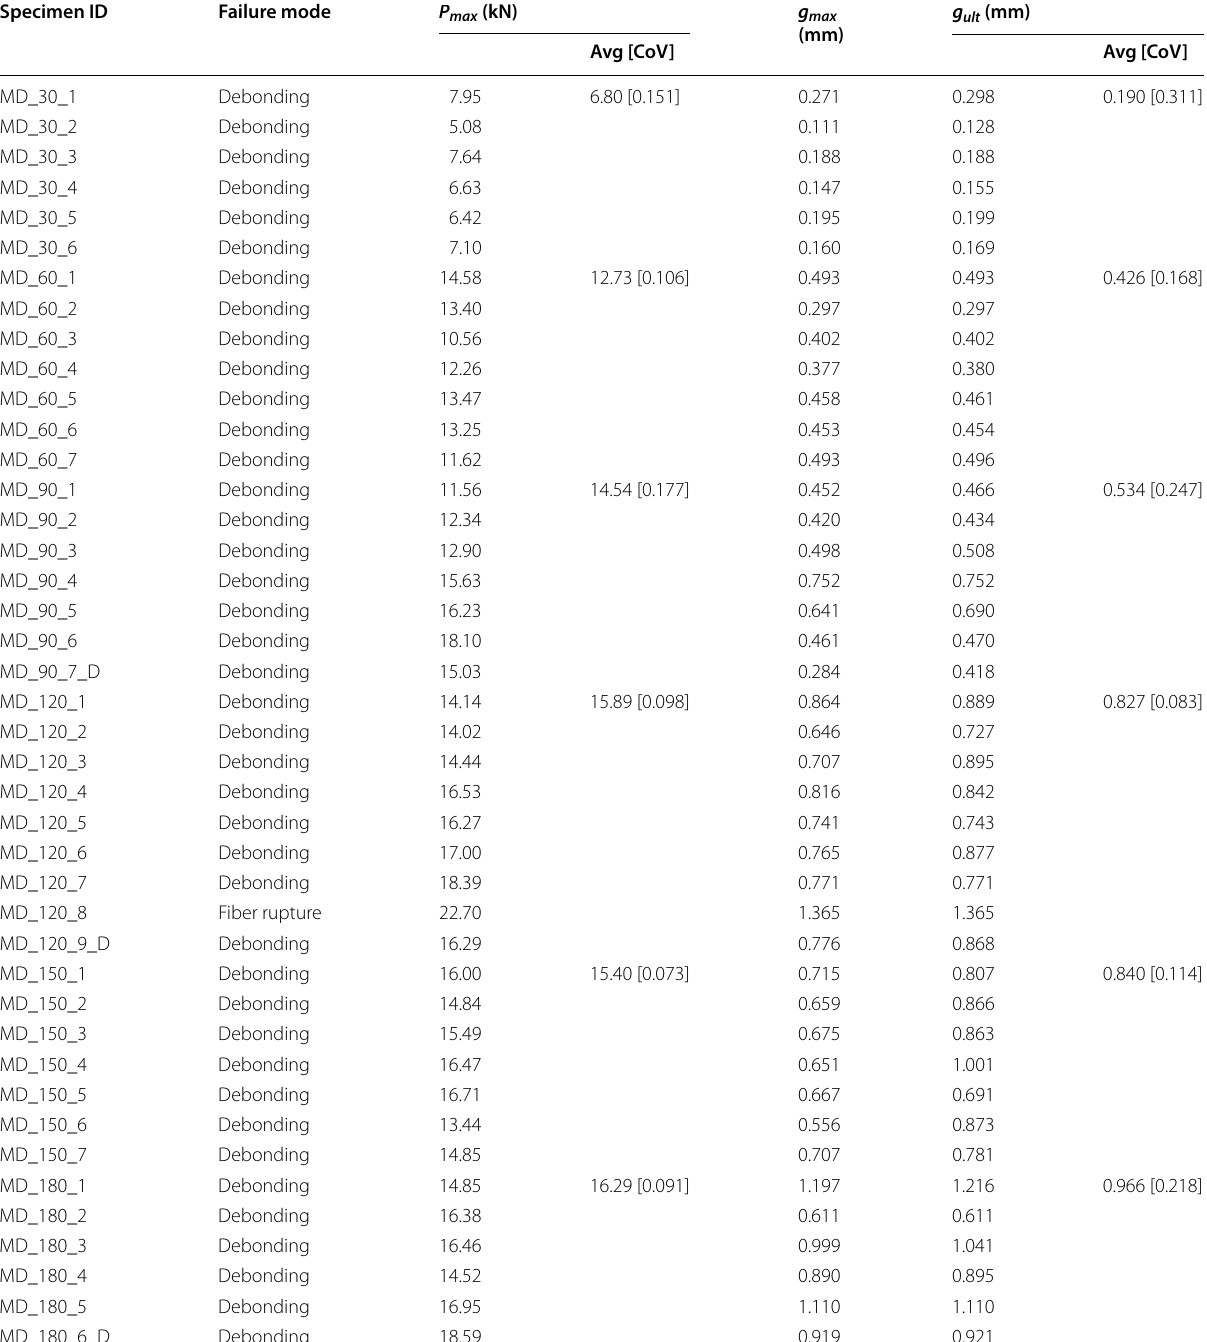
Table 3 Direct shear test results Specimen